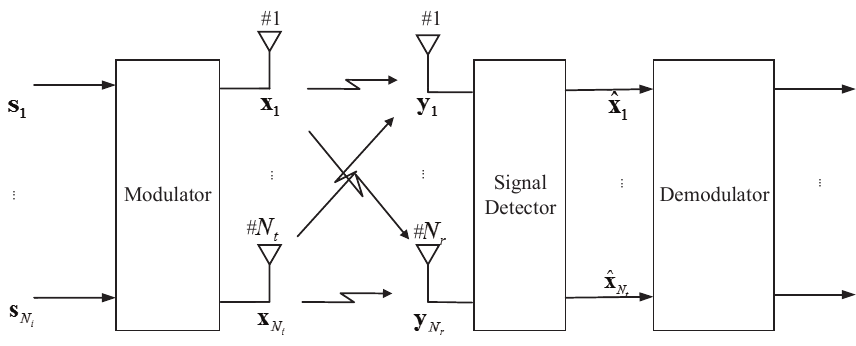
Figure 1. MIMO system signal detection structure